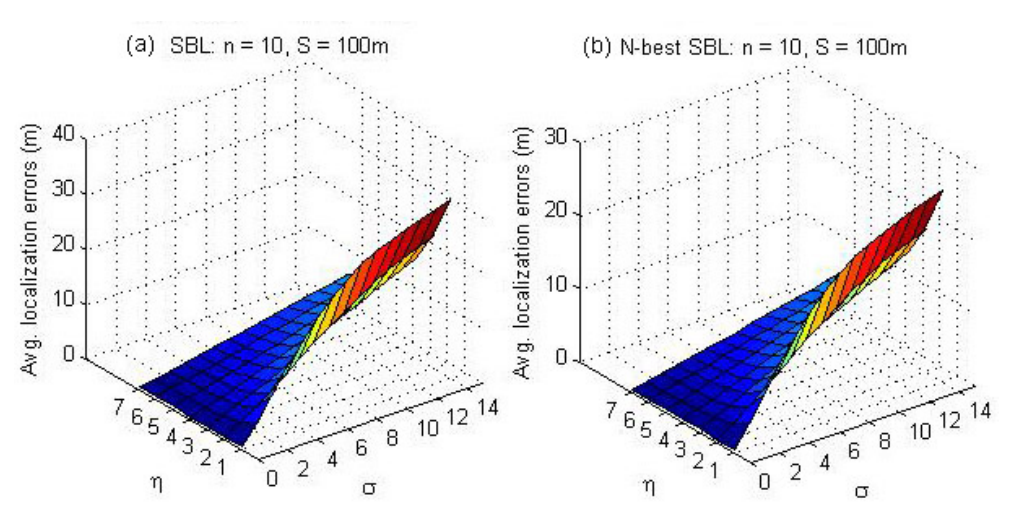
Figure 11. When  = 3 and  = 7, the average localization errors in different regions for the N -best SBL method (a) and the SBL